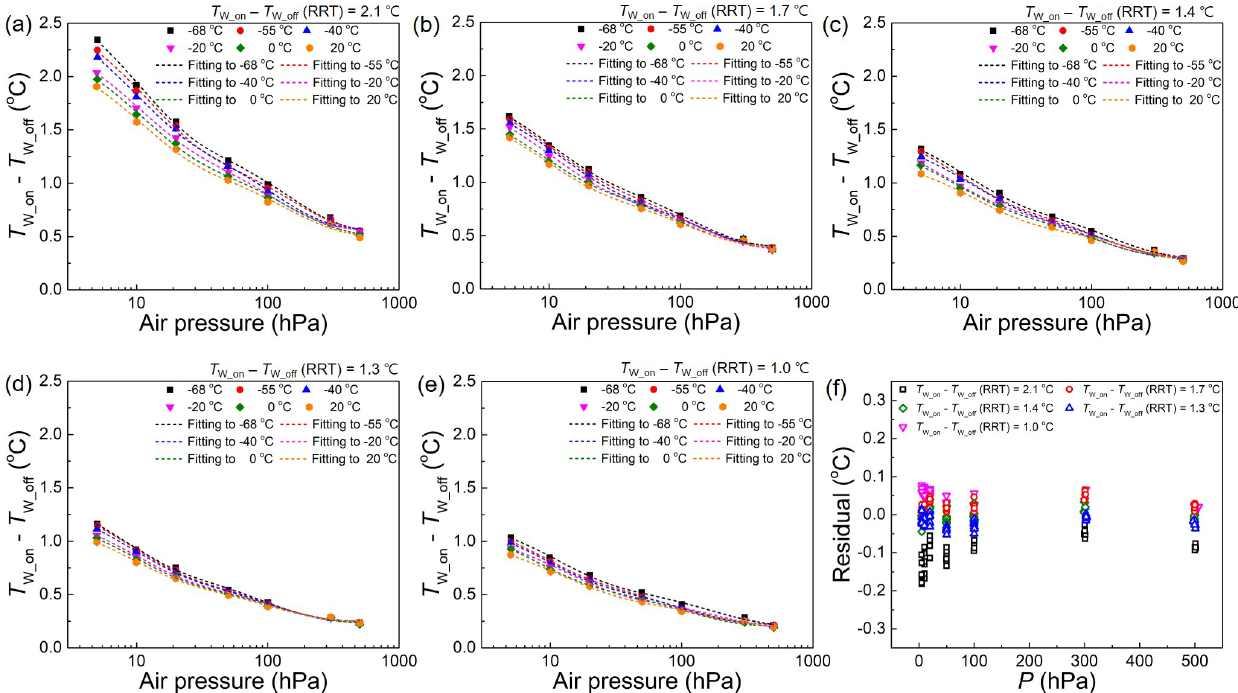
Figure 7. Radiation correction value of white sensors ( T W_on − T W_off ) investigated using UAS. (a–e) ( T W_on − T W_off ) of the five radiosonde white sensors as a function of air pressure with varying temperature. (f) Residual of correction value calculated on the basis of ( T W_on − T W_off ) in UAS and the rotational radiation test.